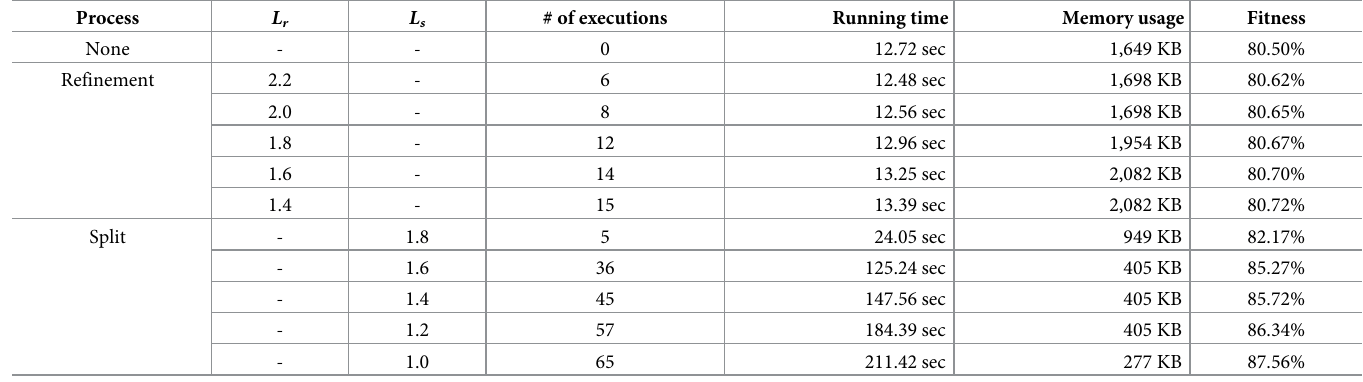
Table 5. Effect of thresholds L and L . The memory usage means the summation of byte allocation to store intermediate data to calculate next decomposition results (e.g. r s auxiliary matrices G and H ). We use Korea Air Quality dataset with rank 20, and change L r and L s to investigate the effect of refinement and split processes. Note that the lower the thresholds is set, the more frequently the re-decomposition processes are executed. Thus, one can benefit from this observation when there is a particular impor- tance in one of accuracy, speed, or memory usage depending on target tasks. Process L # of executions Running r L s